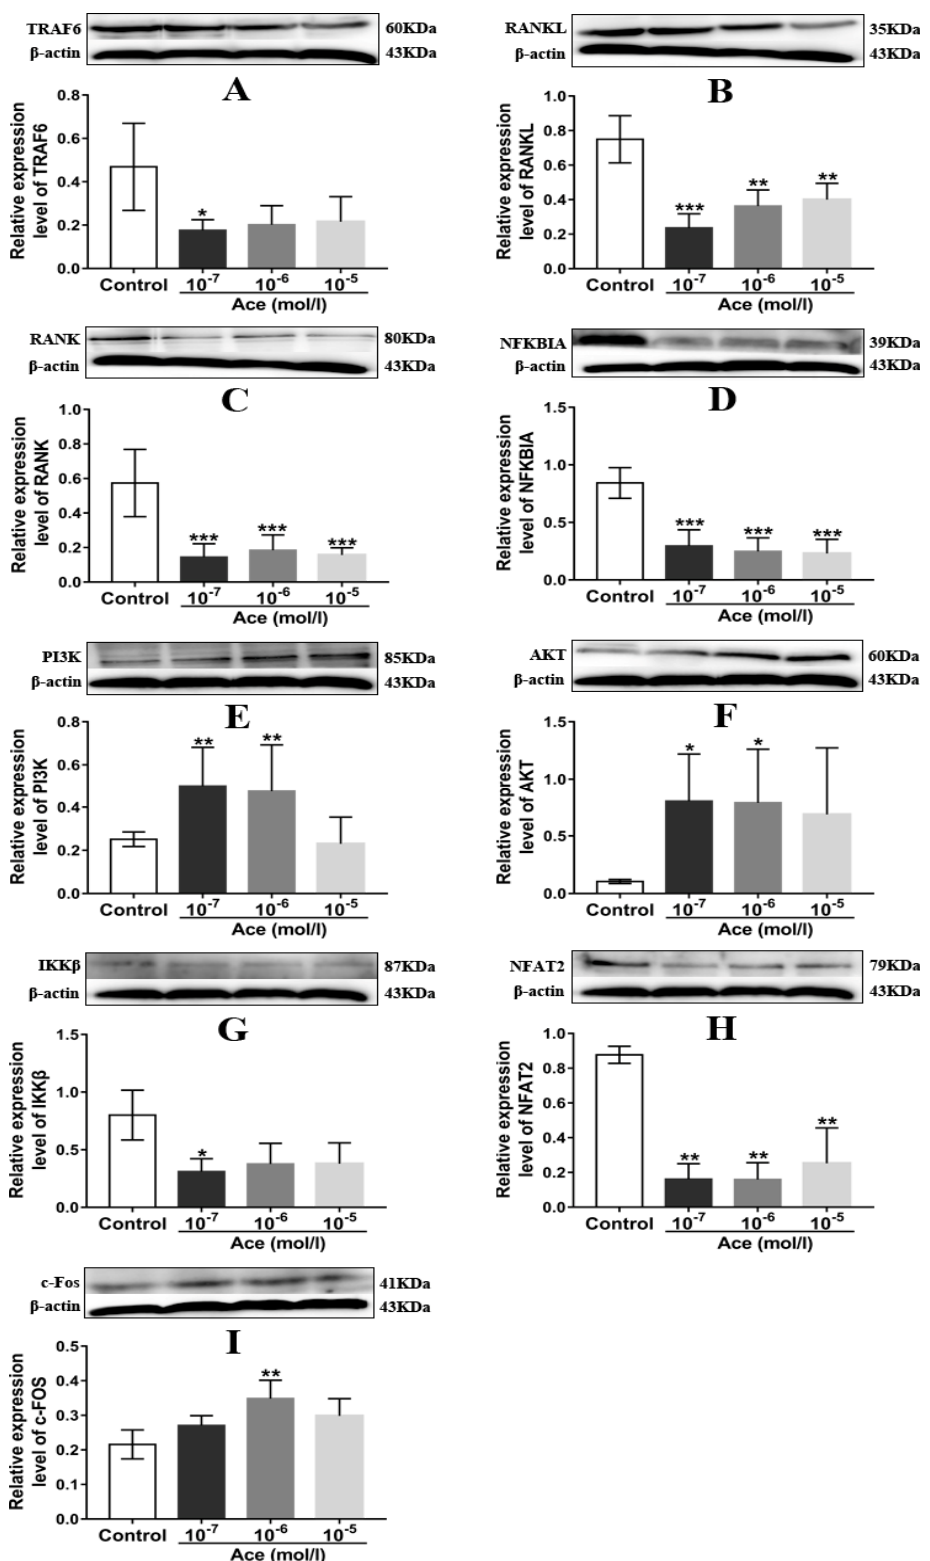
Figure 6. Acteoside treatment on the expression levels of TRAF6 ( A ), RANKL ( B ), RANK ( C ), NFKBIA ( D ), PI3K ( E ), AKT ( F ), IKK β ( G ), NFAT2 ( H ), and c-Fos ( I ) ( n = 3); β -actin was shown as the loading control, and quantitative data of every signal protein was descriptive as percentages of the value of control. Values were expressed as the mean ± SD. * p < 0.05, ** p < 0.01, *** p < 0.001 relative to the control